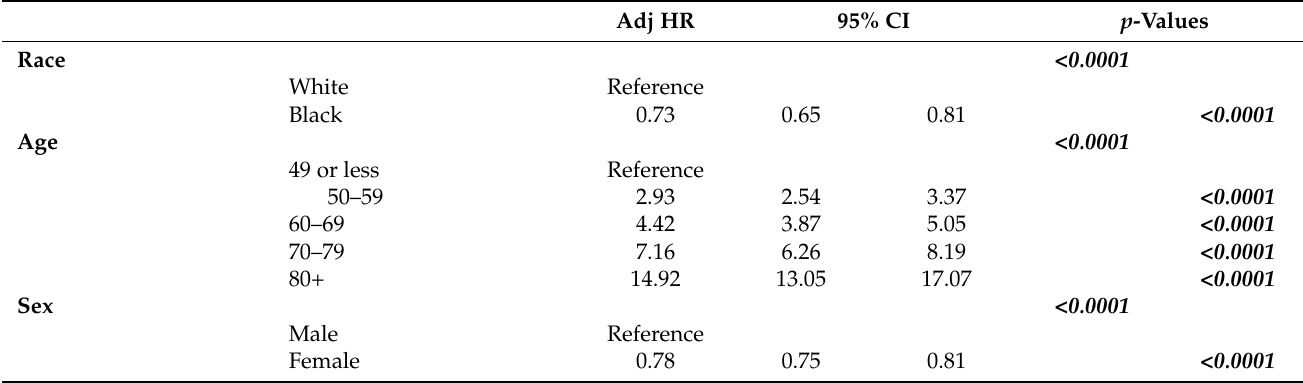
Table 3. Multivariate Cox regression modeling for overall